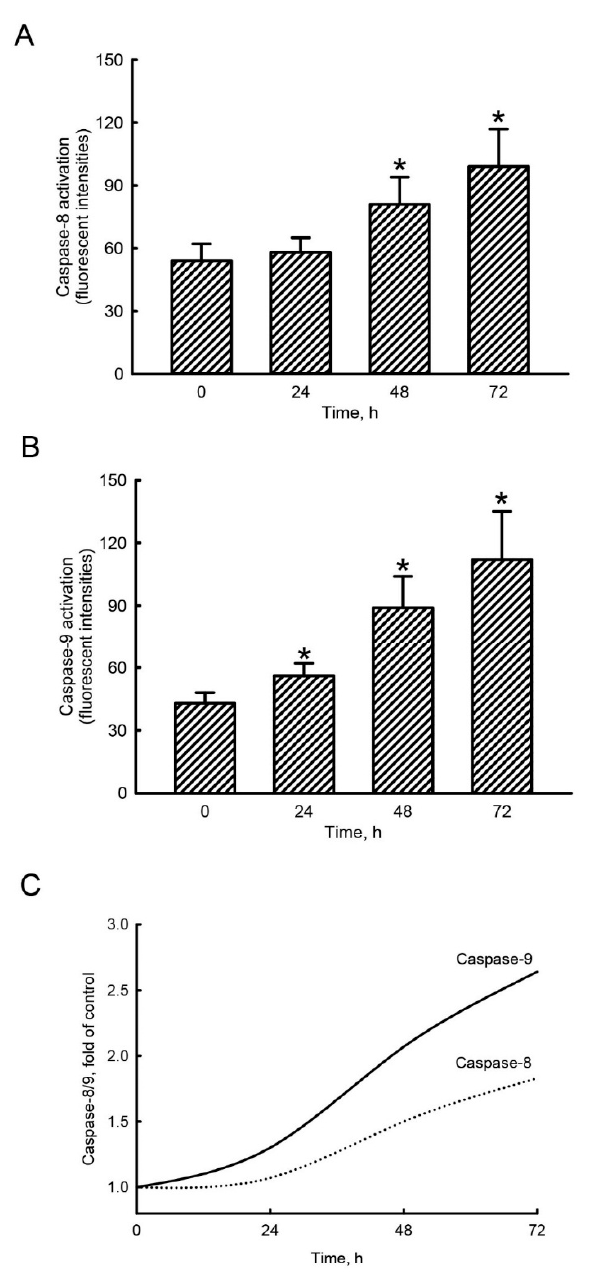
Figure 3. Honokiol mainly induced activation of caspase-9 in human drug-resistant glioblastoma cells. Human TMZ-resistant U87-MG-R9 glioblastoma cells were exposed to 40 µ M honokiol for 24, 48, and 72 h. Activities of caspase-8 ( A ) and -9 ( B ) were measured using fluorogenic substrate methods. E ff ects of honokiol on induction of caspase-8 and caspase-9 were compared cells ( C ). Each value represents the mean ± SD for at least three independent determinations. The symbol * indicates that the value significantly di ff ers from the respective control, p < 0.05.